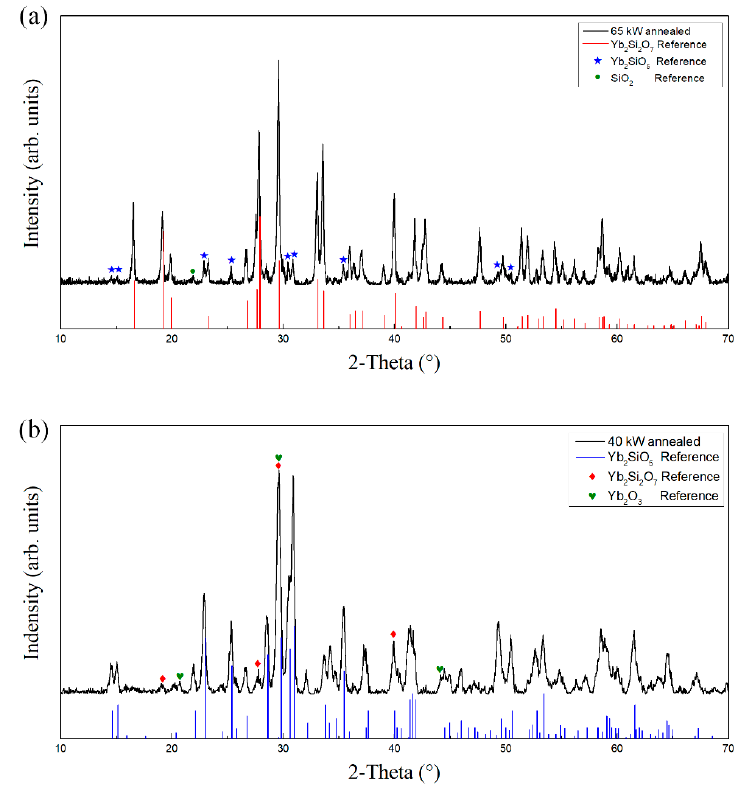
Figure 7. XRD patterns of annealed ytterbium silicate top-coats prepared by ( a ) 65 kW and ( b ) 40 kW.